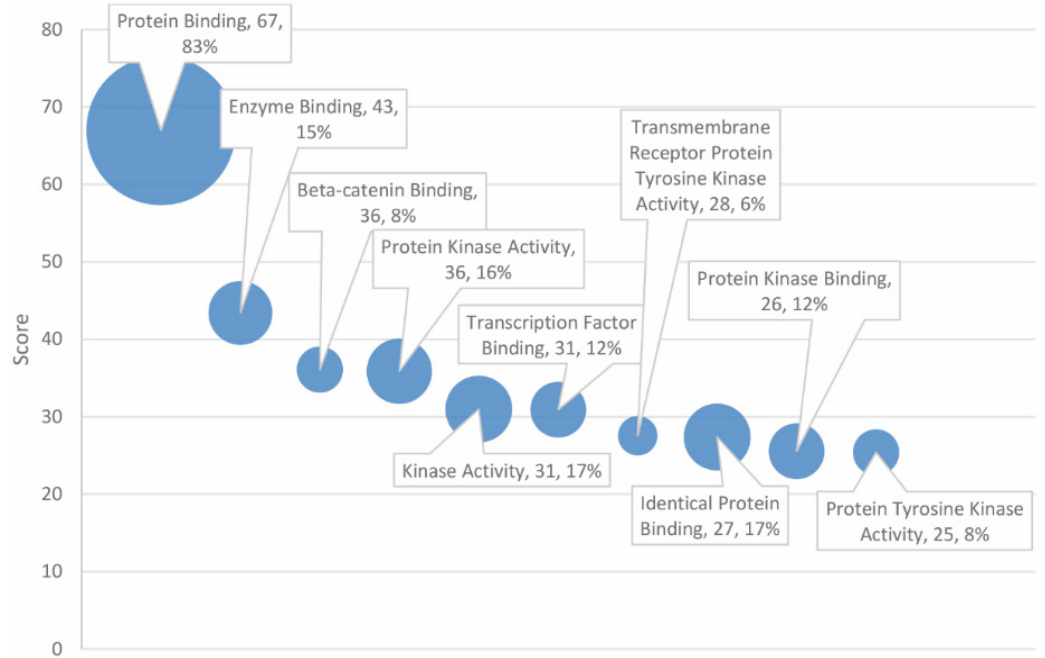
Figure 4. GO molecular function ranked by score and match rate (size of circle) for top ten functions. The 30 top scoring phenotypes, of 145 significant matches, are outlined in Table 5. Phenotypes reflect the importance of ASD and cancer-associated genes in growth and development-related processes (see Figure 5). The top phenotypes include “premature death” (score = 70, 28% match rate), “complete embryonic lethality during organogenesis” (score = 53, 20% match rate), and “decreased body size” (score = 51, 22% match rate). Table 5. Profiling of high scores in overlapping genes for autism and cancer-associated phenotypes. Score